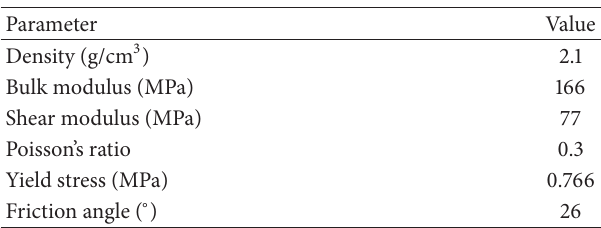
Table 4: Parameter of foundation